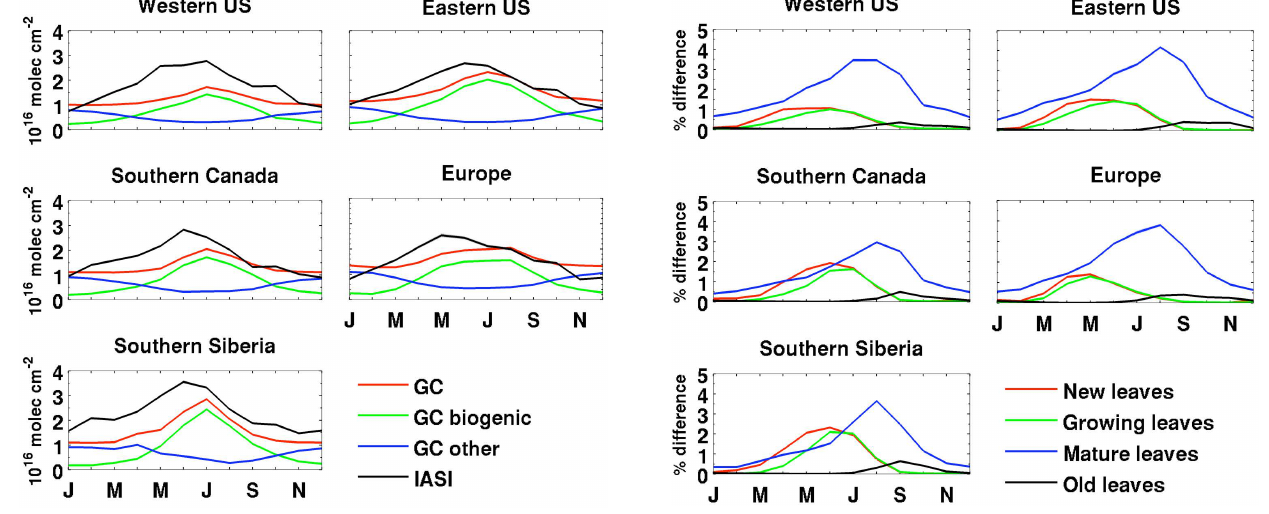
Fig. 5. Seasonal source contributions to atmospheric methanol for the northern midlatitude regions of Fig. S2 in the Supplement: Western US (35–50 ◦ N, 120–100 ◦ W), Eastern US (35–50 ◦ N, 100– 60 ◦ W), Southern Canada (50–60 ◦ N, 130–60 ◦ W), Europe (40– 50 ◦ N, 0–30 ◦ E), and Southern Siberia (50–65 ◦ N, 80–140 ◦ E). Shown are 2009 timelines of the methanol column as measured by IASI (black) and simulated by GEOS-Chem (base-case simulation, red). The individual model contributions from biogenic (green) and all other sources (blue) are also shown. Lines show the mean over each region.